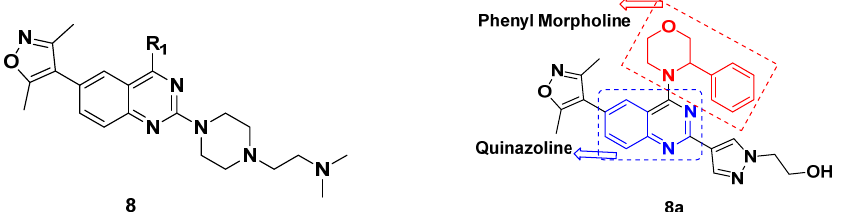
Figure 8. Structure of quinazoline-artemisinin based hybrid 7 .